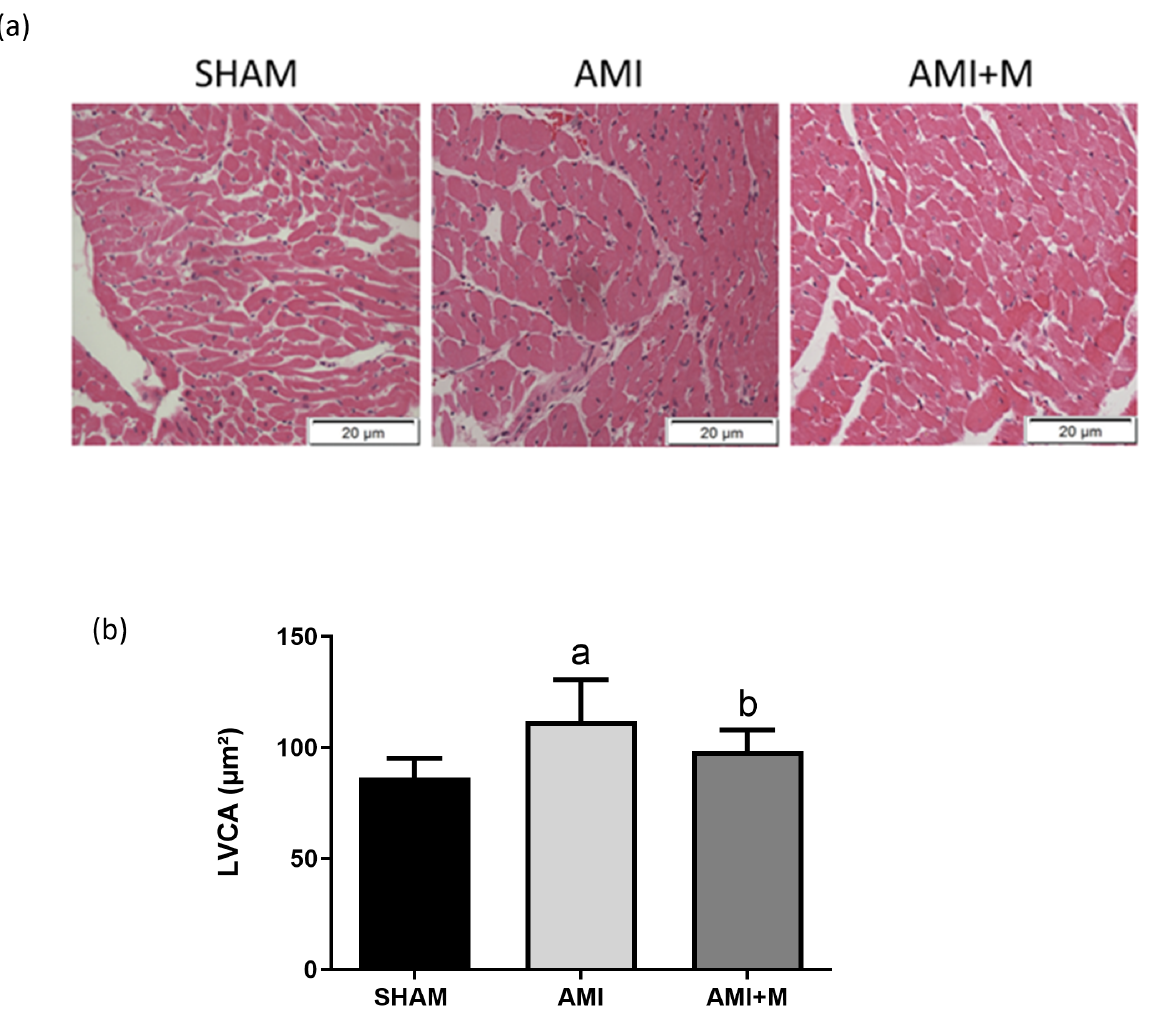
Figure 4. (a) Illustration of left ventricular histology, cross section at 200x magnification and staining of hematoxicillin and eosin (HE). (b) Quantification of left ventricular cardiomyocytes area (LVCA, µm 2 ). Results are expressed as mean ± SD from 7 to 8 animals per group. a p<0.05 as compared to SHAM. b p<0.05 as compared to